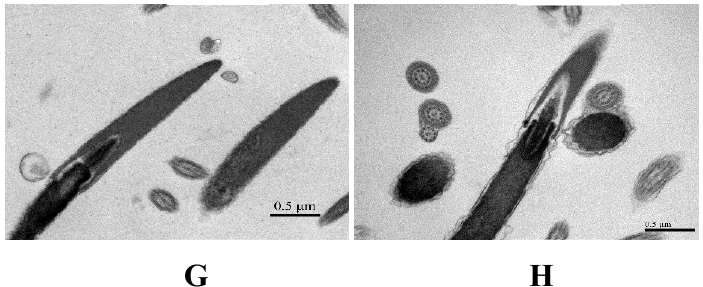
Figure 3. Scanning and transmission electron microscopy of fresh chicken sperm and post-thaw chicken sperm (scanning electron microscope, Hitachi SU8010, Japan; transmission electron microscope, Hitachi H-7500, Japan). ( A ) Fresh sperm mitochondria (scale bar = 1 μ m at 40,000× magnification); ( B ) Post-thaw sperm mitochondria (scale bar = 2 μ m at 22,000× magnification); ( C ) Fresh sperm perforatorium (scale bar = 1 μ m at 40,000× magnification); ( D ) Post-thaw sperm perforatorium (scale bar = 1 μ m at 30,000× magnification); ( E ) Fresh sperm mitochondria (scale bar = 0.5 μ m at 70,000× magnification); ( F ) Post-thaw sperm mitochondria (scale bar = 0.5 μ m at 40,000× magnification); ( G ) Fresh sperm perforatorium (scale bar = 0.5 μ m at 40,000× magnification); ( H ) Post-thaw sperm perforatorium (scale bar = 0.5 μ m at 25,000× magnification).